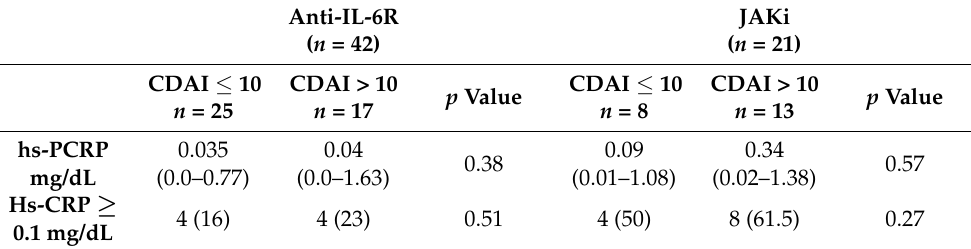
Table 5. Patients classified according by group and disease activity according to